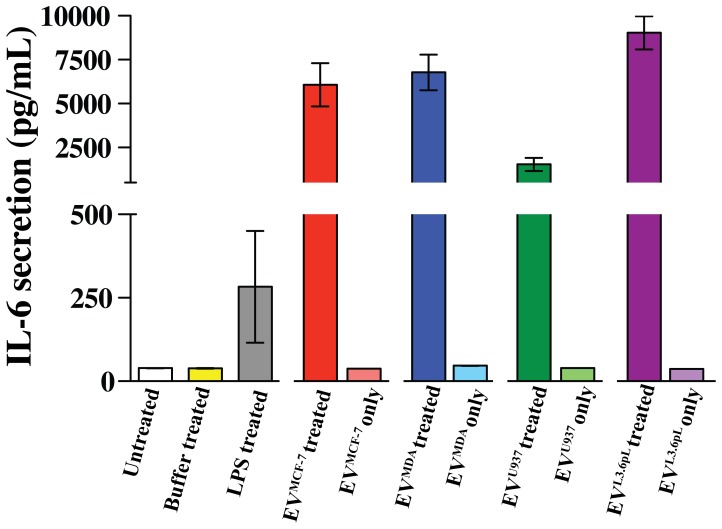
IL-6 is secreted upon stimulation with EVs in THP-1 cells.IL-6 secretion in THP-1 cells was measured with an ELISA assay upon stimulation with EVMCF-7, EVMDA, EVU937 and EVL.6pL. The EVs secrete low levels of IL-6 that did not contribute significantly to the overall observed secreted IL-6 levels.